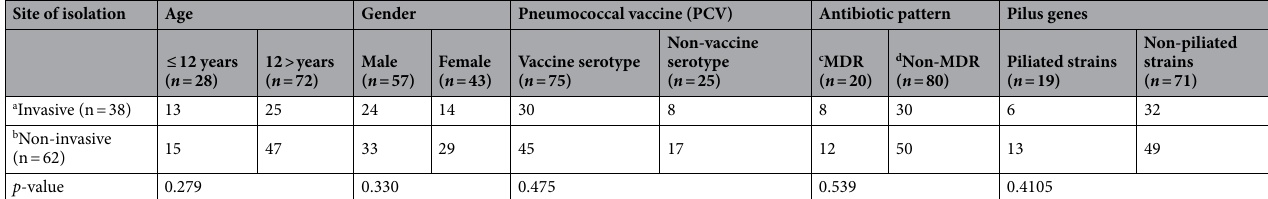
Table 2. Isolation sites of the pneumococcal isolates in relation to gender, vaccine serotypes, and multidrug- resistance. a Invasive site (blood). b Non-invasive site (sputum, eye, pus, bronchiol, swab). c MDR = resistance to ≥ 3 antibiotics. d Non-MDR = resistance to < 3 antibiotic(s).